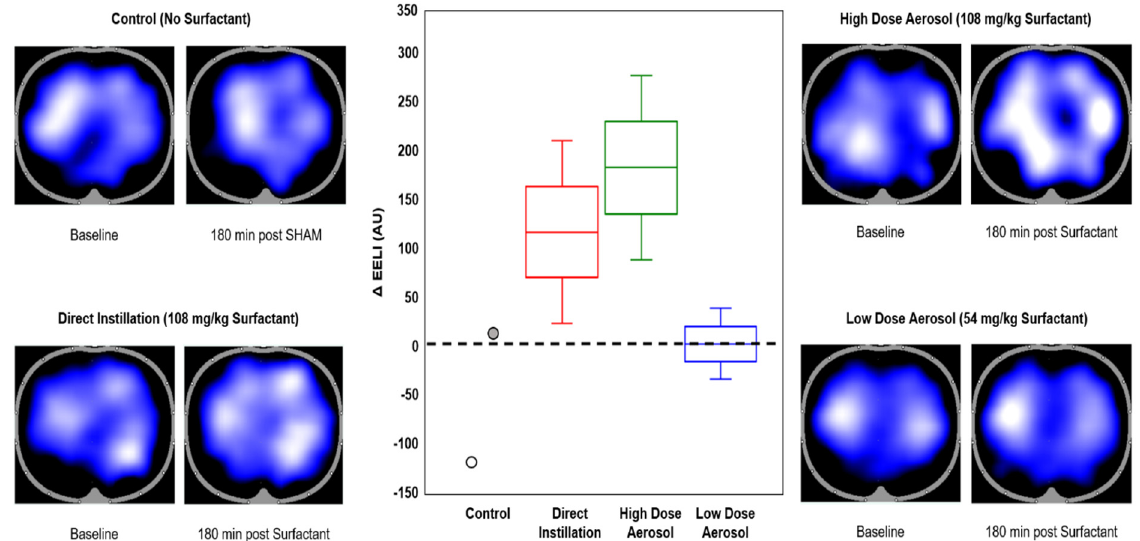
Figure 5. Electrical Impedance Tomography (EIT) and end-expiratory lung volume ( ∆ EELV). Representative EIT images at baseline (post-lavage) and 180 min after intervention with Control ( upper left ), Direct Instillation ( upper right ), High Dose Aerosol ( lower right ) and Low Dose Aerosol ( lower left ). The dark areas of the EIT images represent areas with no ventilation with blue representing areas of increased ventilation distribution with white coloring showing maximal ven- tilation. Representative images were typical of animals with similar oxygenation response following surfactant replace- ment. The box (median and interquartile range) and whisker (minimum and maximum ranges) plot depicts relative changes in EELI (Au) between baseline and 180 min condition ( center ). There were no differences in Δ EELI between groups ( p = 0.3). Relative improvement in alveolar recruitment and recovery from baseline was observed with increased Δ EELI in both high dose Direct-Instillation and Aerosol groups; whereas Control group showed evidence of alveolar collapse and consolidation over 180 min and Low Dose Aerosol showed no improvement.